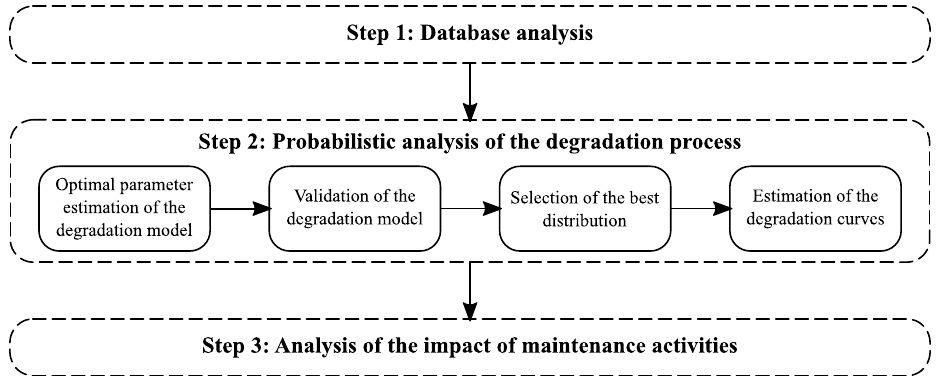
Figure 1. Diagram of the methodology implemented in this